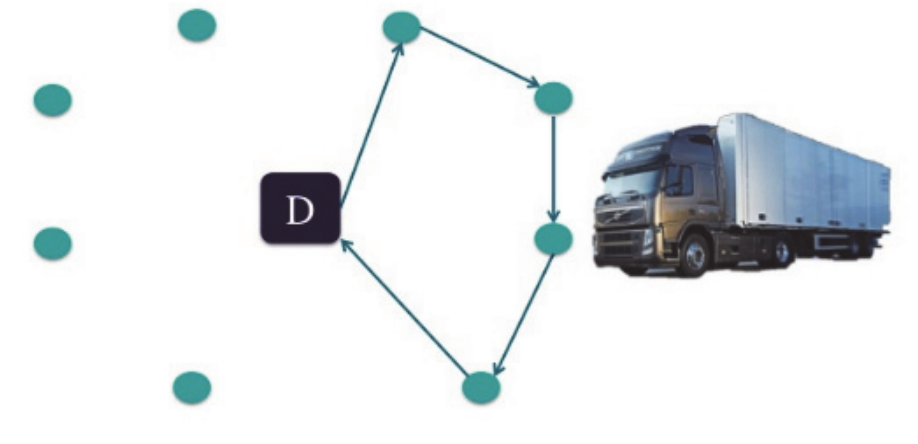
Fig. 1. Proposed VRP